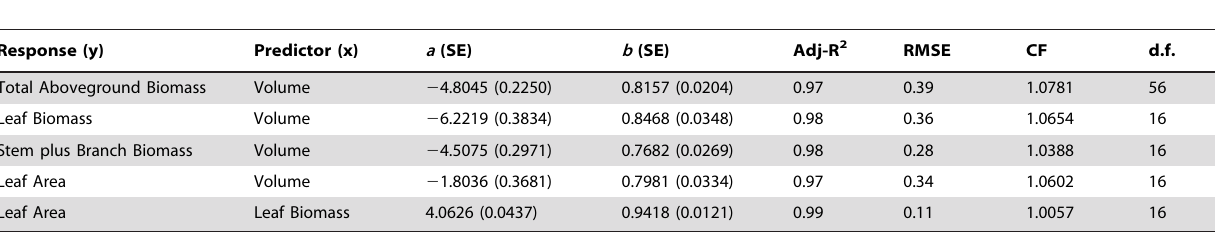
Table 2. Selected allometric equations for freeze-affected black mangrove ( Avicennia germinans ) individuals.